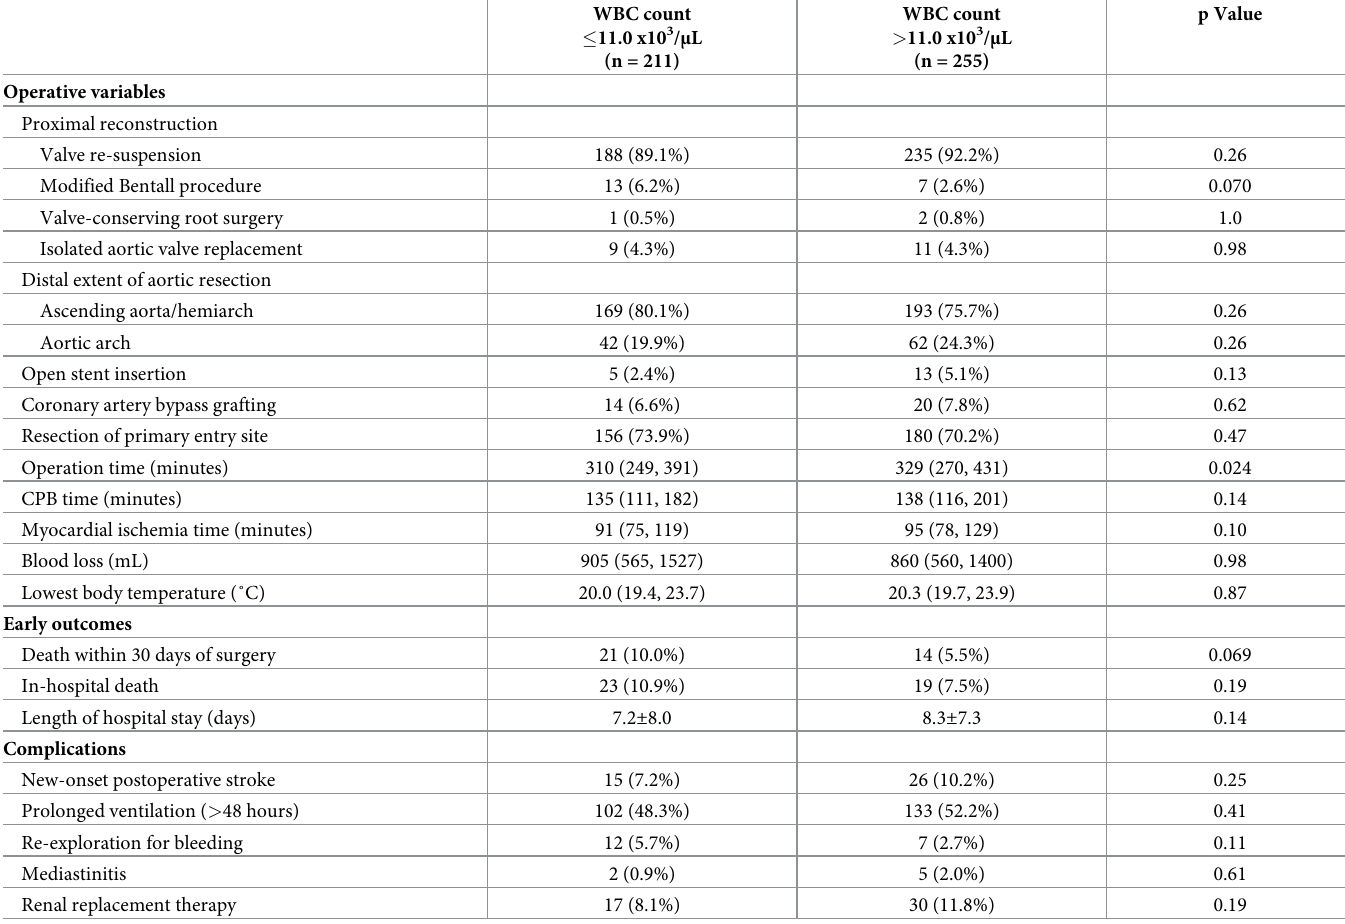
Table 4. Operative variables and early outcomes, per white blood cell count ( � 11.0 x10 3 / μ L vs. > 11.0 x10 3 / μ L).